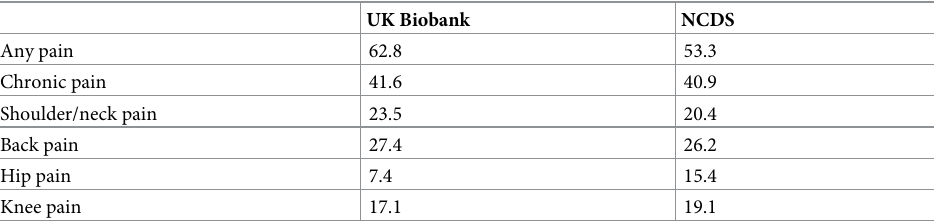
Table 3. Pain prevalence